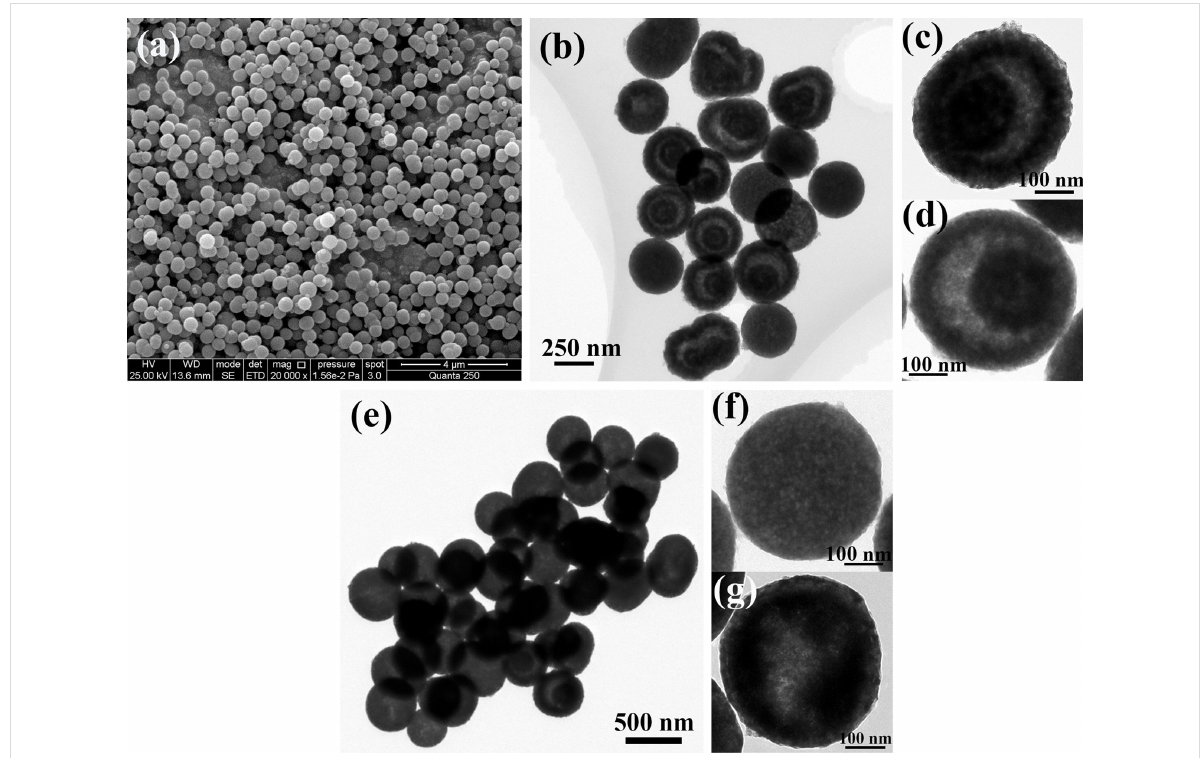
Figure 2: SEM image of Ce-CPCSs (a) and TEM images of (b–d) the CeO 2 yolk-shell nanospheres (heating rate 8 °C/min) and of (e–g) solid nano- spheres (heating rate 2 °C/min).